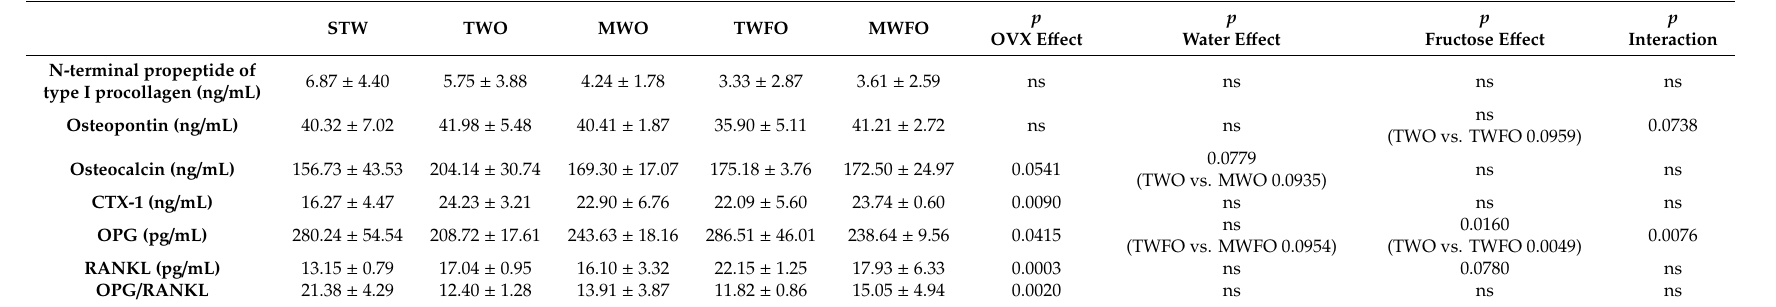
Table 3. Circulating markers of bone